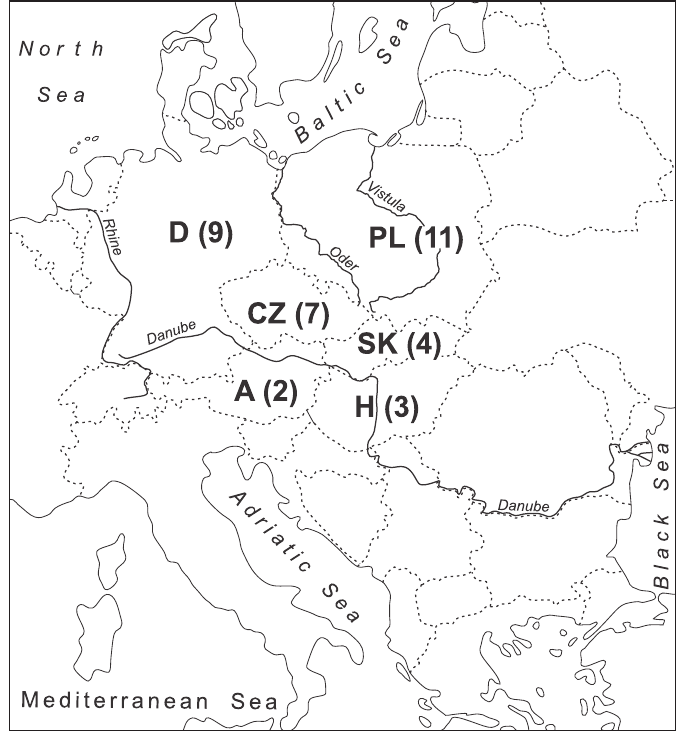
Figure 1. Number of stygobitic oligochaete species known from the countries of Central